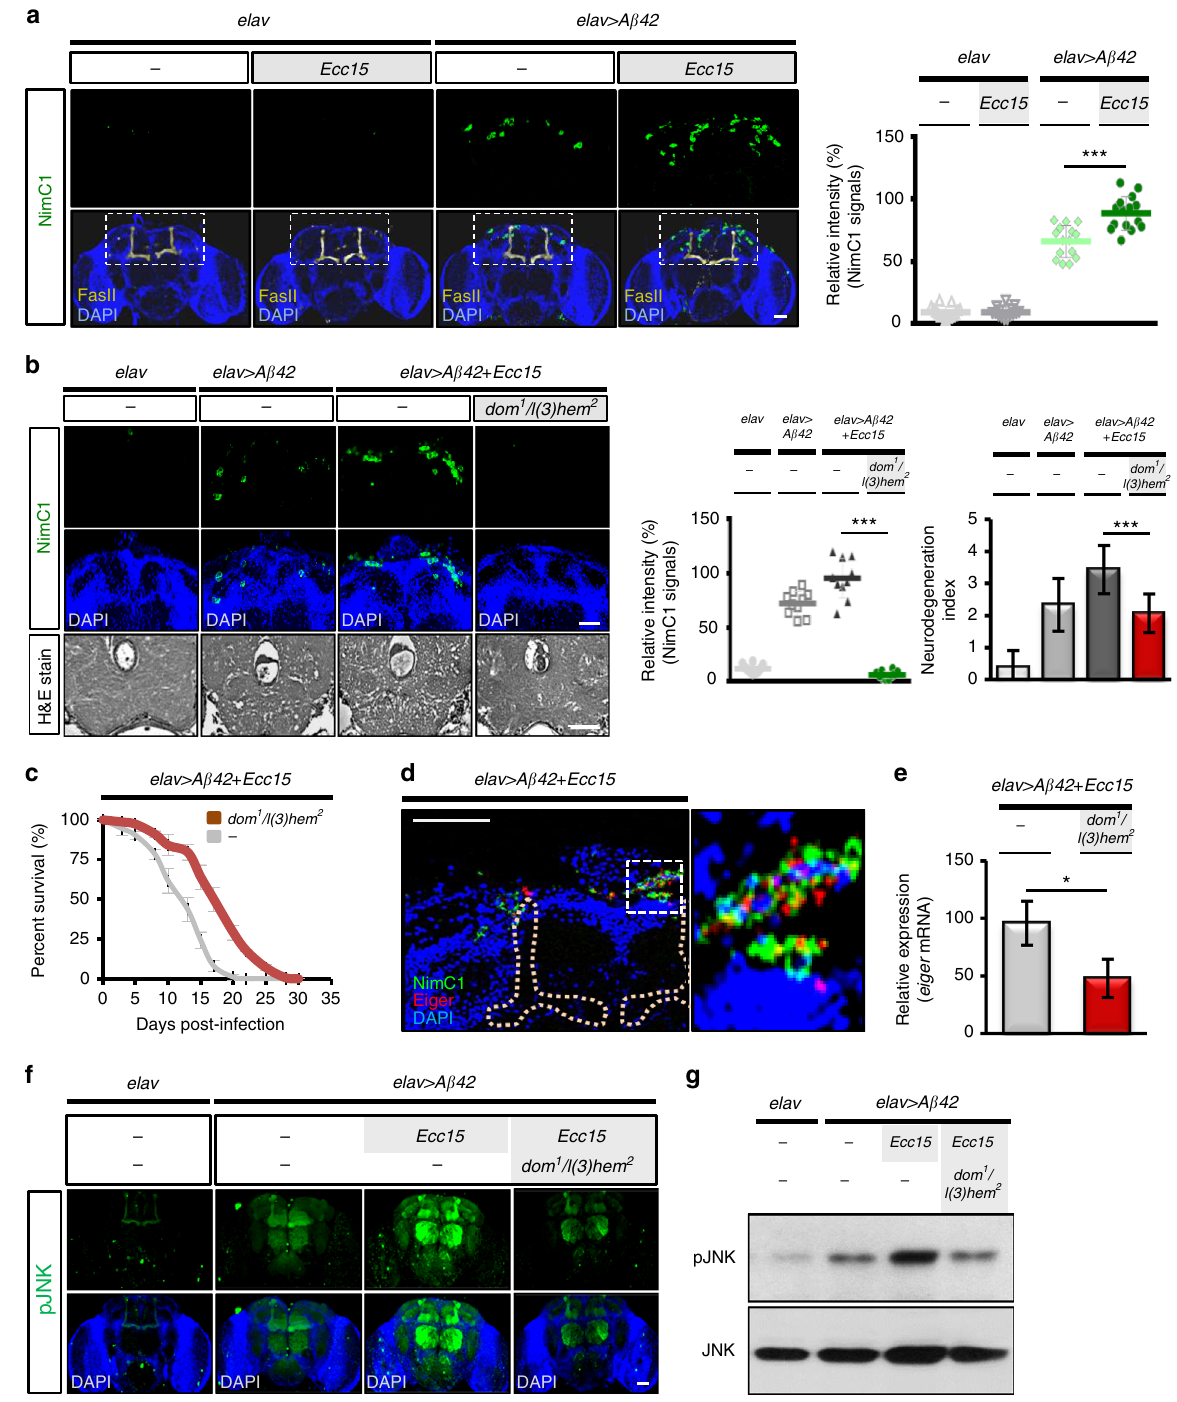
Fig. 3 Macrophage recruitment to amyloid transgenic fl y brain aggravates neurodegeneration upon intestinal infection. a Immunostaining of plasmatocyte ( green , NimC1 signals) recruited to the transgenic brain upon intestinal infection; n = 15 in each group for quanti fi cation ( right panel). yellow , mushroom body (FasII signals); blue , DAPI signal; left panel. b , c Immunostaining of the recruited hemocytes ( upper and middle panels) and brain histology ( lower panel) b and life span analysis c in the transgenic fl ies with or without dom 1 /l(3)hem 2 hemocyte-de fi cient background. Green , NimC1 signals; blue , DAPI signal; n = 10 in each group for quanti fi cation of brain histology; n = 100 in each group for lifespan assay. d Coimmunostaining of NimC1 and Eiger in brains of the Ecc15 -infected transgenic fl ies. ( Right panel shows high magni fi cation view from white dotted line labeled region of left panel). The location of Mushroom body is masked with yellow dotted lines; Eiger, red ; recruited plasmatocytes, green ; transgenic brain, blue . e – g qRT-PCR analysis of eiger expression e and immunostaining f as well as western blot analysis g of JNK phosphorylation in brains of the transgenic fl ies with or without hemocyte- de fi cient background. Quantitative data are presented as the mean ± SD of three independent experiments. elav > A β 42 transgenic or control ( elav alone) fl ies with or without Ecc15 intestinal infection were analyzed at 10 dpi for plasmatocyte recruitment, eiger expression, and JNK activation. * P < 0.05, *** P < 0.001; NS, not signi fi cant, H&E, haematoxylin and eosin. Scale bars, 50 μ